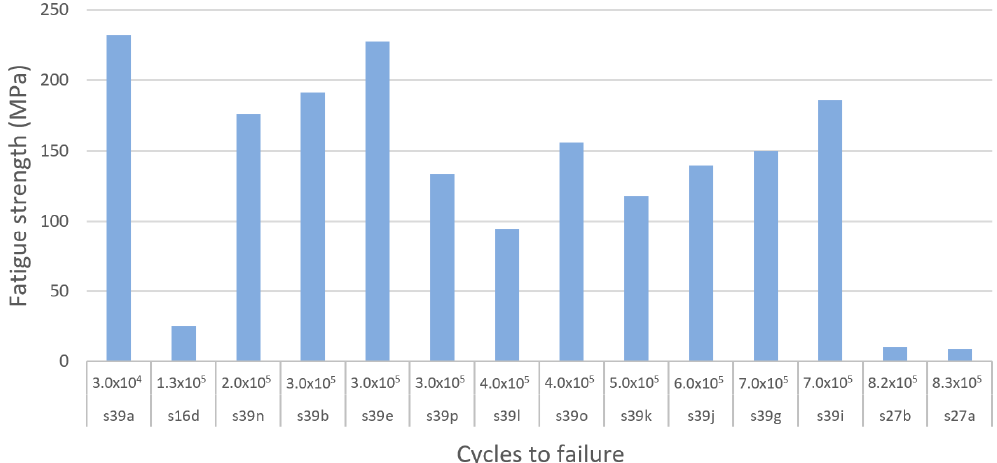
Figure 19. Comparison of the results of different studies on the fatigue strength of porous metamaterials based on triply periodic minimal surfaces (TPMS) within the high-cycle fatigue region between 10 4 and 10 5 cycles.